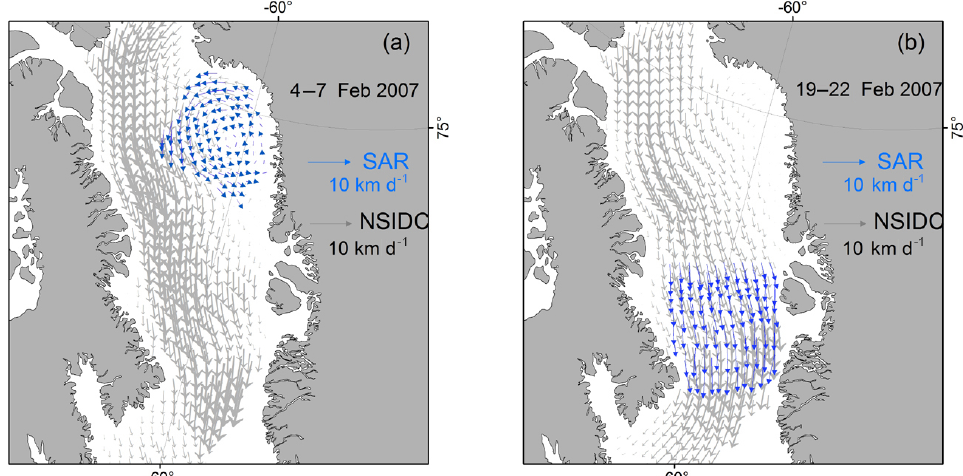
Figure 3. Sea ice motion examples from NSIDC and Envisat. Gray arrows corresponds to the NSIDC data. The superimposed blue arrows, one for 4–7 February 2007 (a) and the other for 19–22 February 2007 (b) , denote the corresponding Envisat